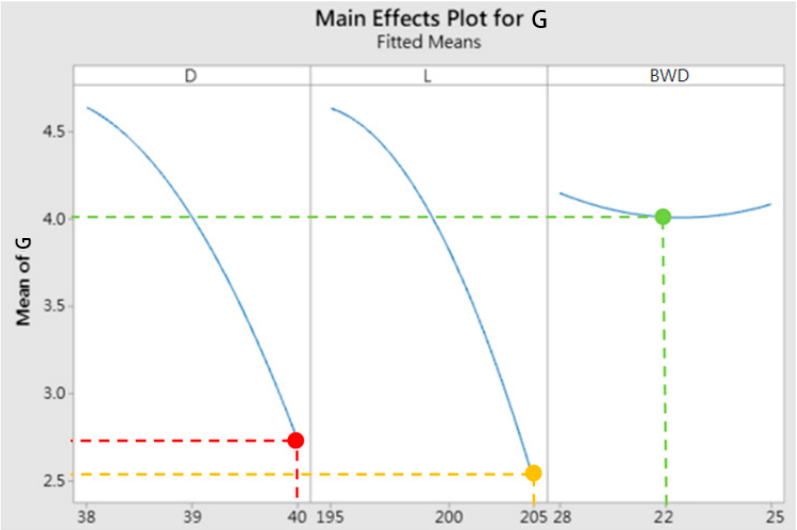
Figure 7. Main effects plot of the gap (G) between the top die and the bottom die.